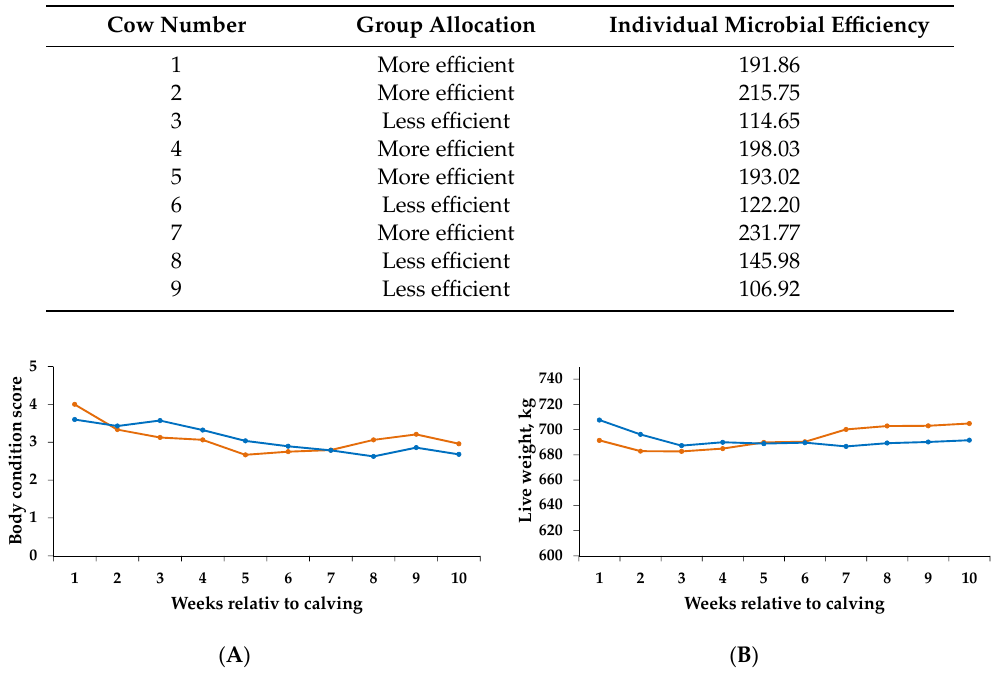
Figure A1. Progress of body condition score (A) and live weight (B) during the first 10 weeks postpartum. After calving cows were assigned to a group with 60% concentrate feed proportion (increasing from 35-60% during the first three weeks after parturition, C 60 , orange , n = 5) and a group with 35% concentrate feed proportion ( C 35 , blue , n = 4) in the ration. Table A3. Effects of microbial efficiency (synthesized microbial crude protein/fermented organic matter) on dry matter intake (DMI), milk yield, energy corrected milk (ECM) and milk components during the week of duodenal chyme sampling.